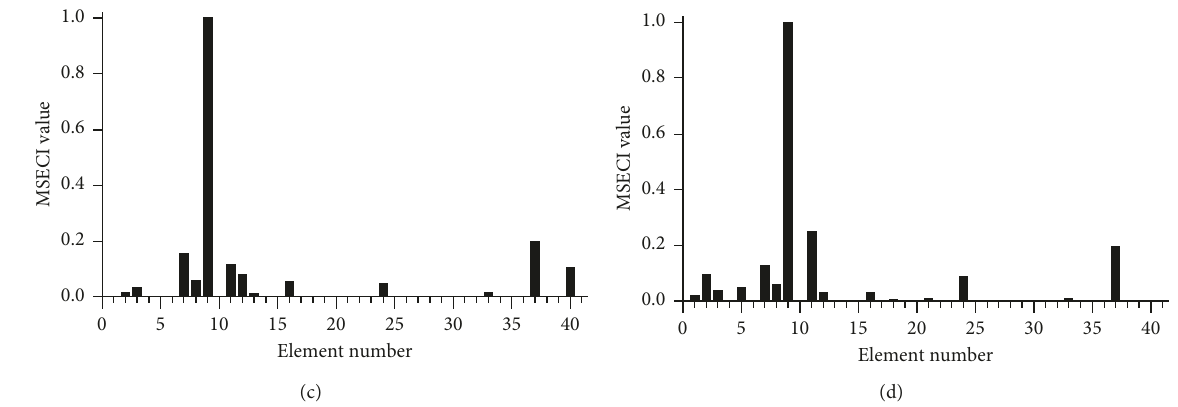
Figure 6: Values of the proposed MSECI using the first several modes together (damaged element 9, without noise). (a) Using modes 1-2. (b) Using modes 1–4. (c) Using modes 1–6. (d) Using modes 1–8.